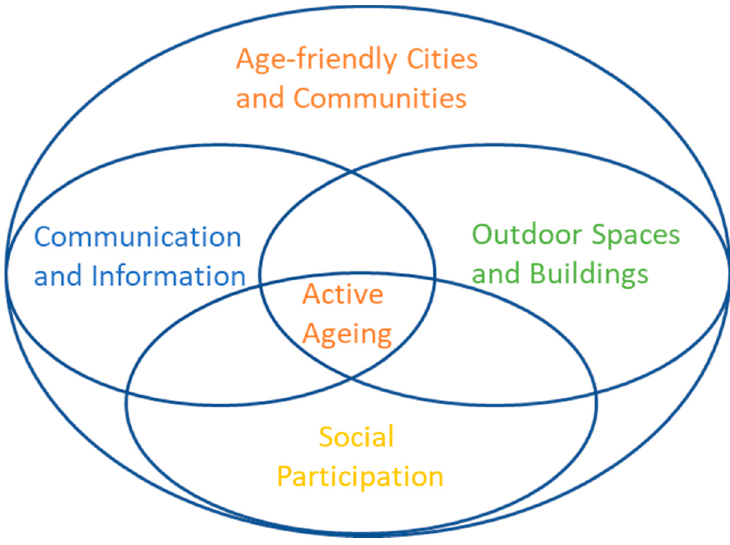
Figure 1. Convergence of age-friendly domains.